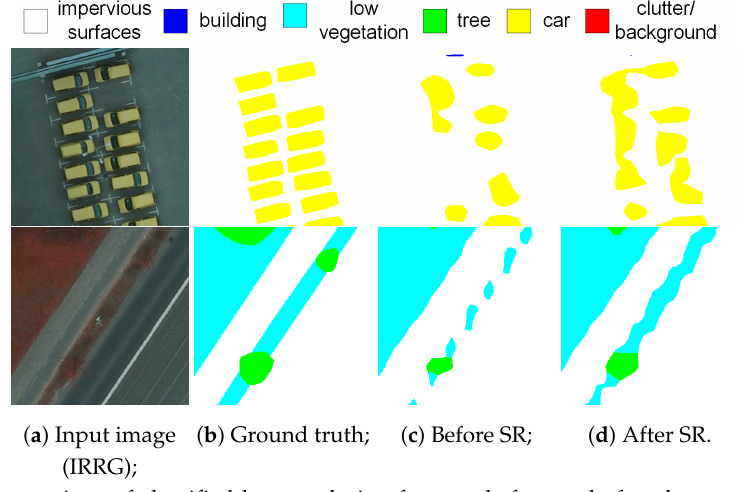
Figure 7. Comparison of classified low-resolution features before and after the use of the spatial reasoning (SR) module (Potsdam dataset).